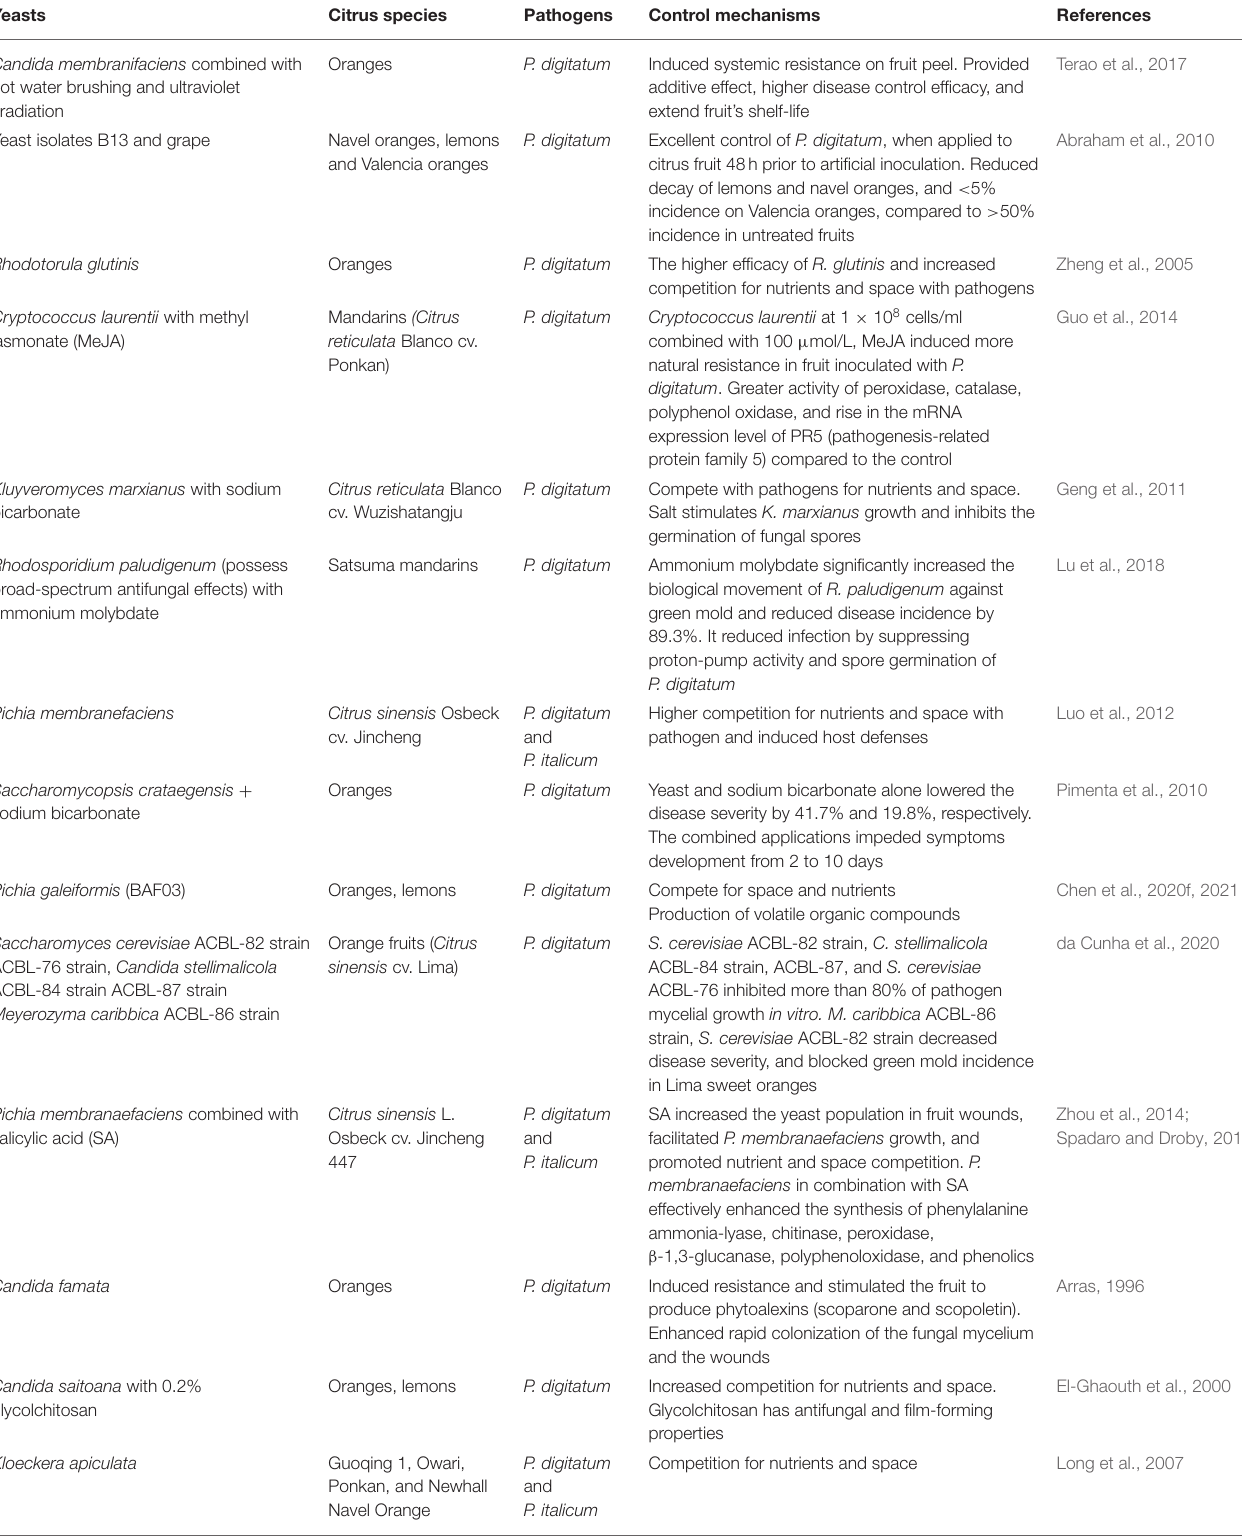
TABLE 1 | Antagonistic microorganisms for the control of P. digitatum and P. italicum